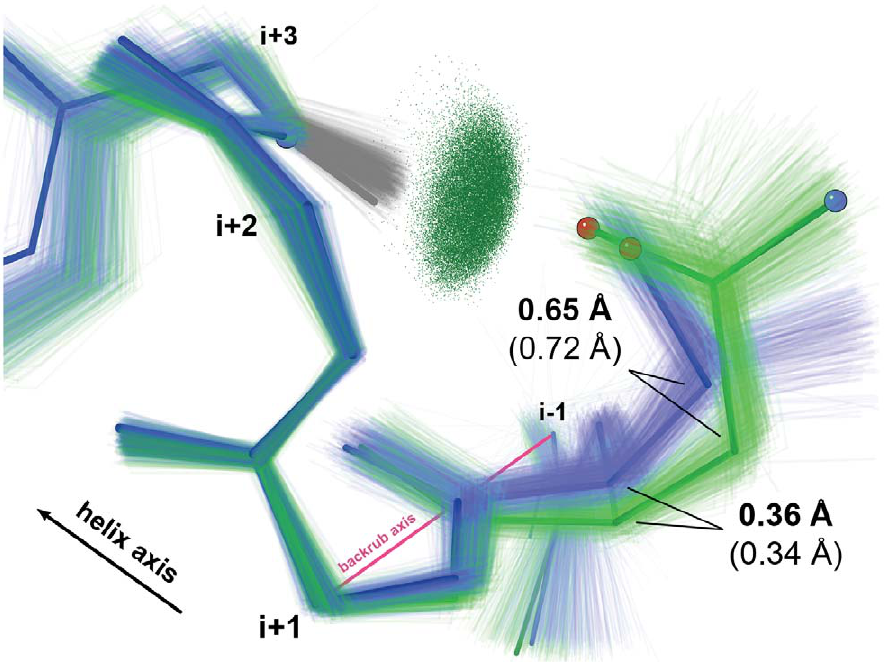
Figure 3. Backrubs at a -helix N-caps. Crystal structure ensembles for Asn/Asp (light green) vs. Ser/Thr (light blue) at the N-cap position are related by a backrub. Lowest-energy BRDEE conformations for the N-terminus of an ideal a -helix (see Methods) with Asn (dark green) vs. Ser (dark blue) have a closely similar relationship. C a and C b displacements between Asn/Asp and Ser/Thr for both average crystal structures (lighter, in parentheses) and low-energy BRDEE conformations (darker) evoke a hinge-like backrub operation. Ensemble i + 3 sidechain-mainchain N-cap H-bonds are illustrated with ‘‘pillows’’ of green all-atom contact dots [44].